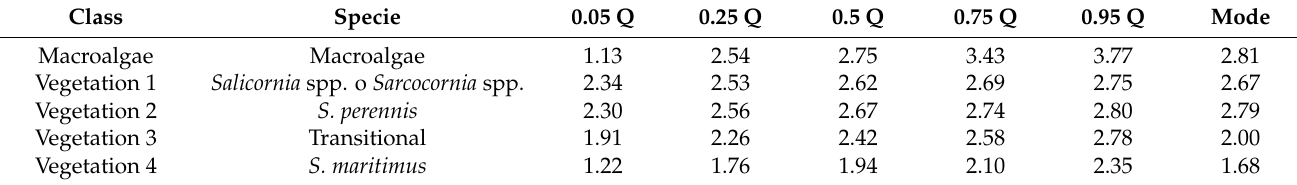
Table 3. Estimated elevation range for each salt marsh vegetation class identified in Cadiz